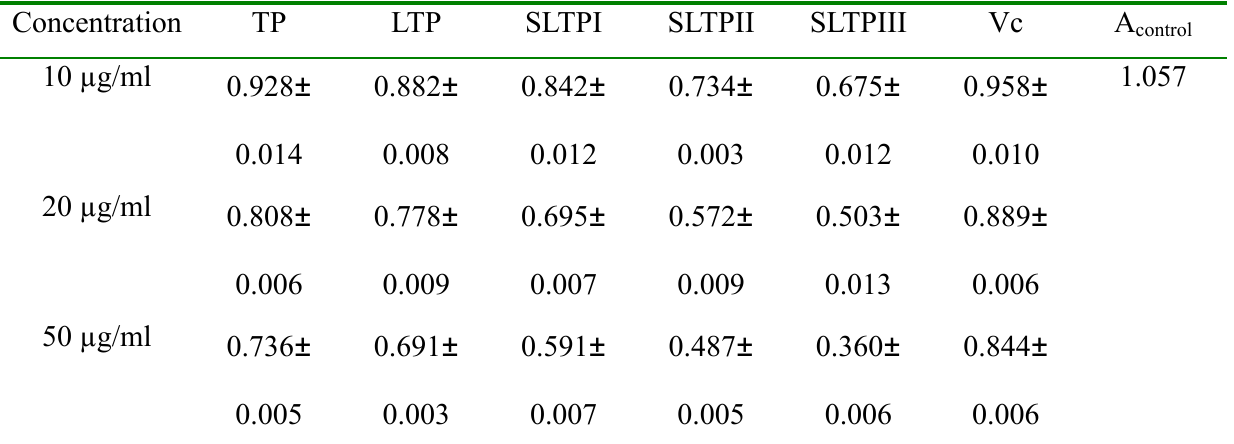
Table 3. Absorbance of natural TP, its derivatives and Vitamin C at 532nm.